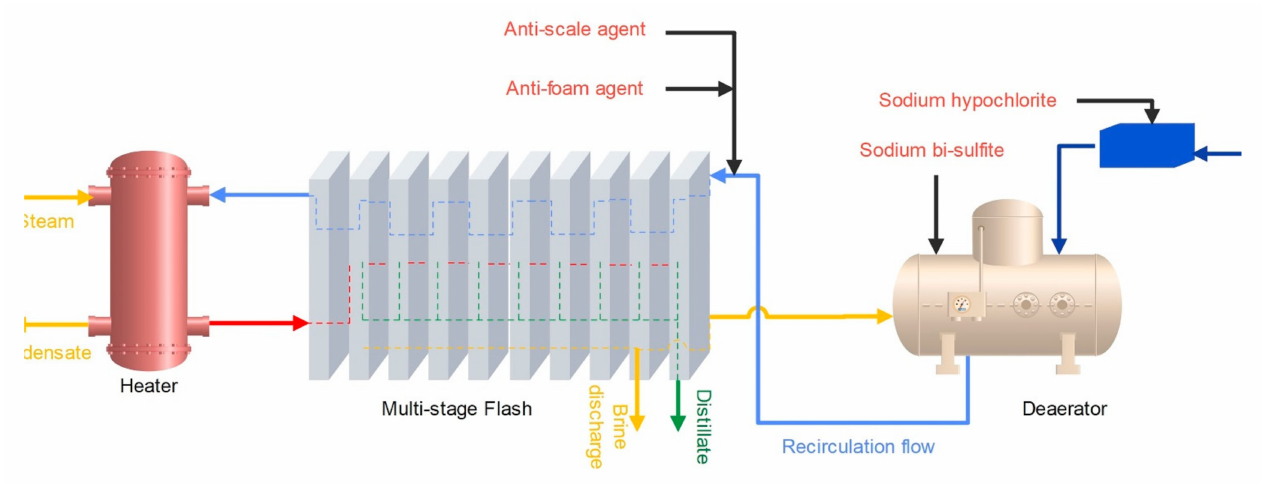
Figure 2. The schematic of the R-MSF